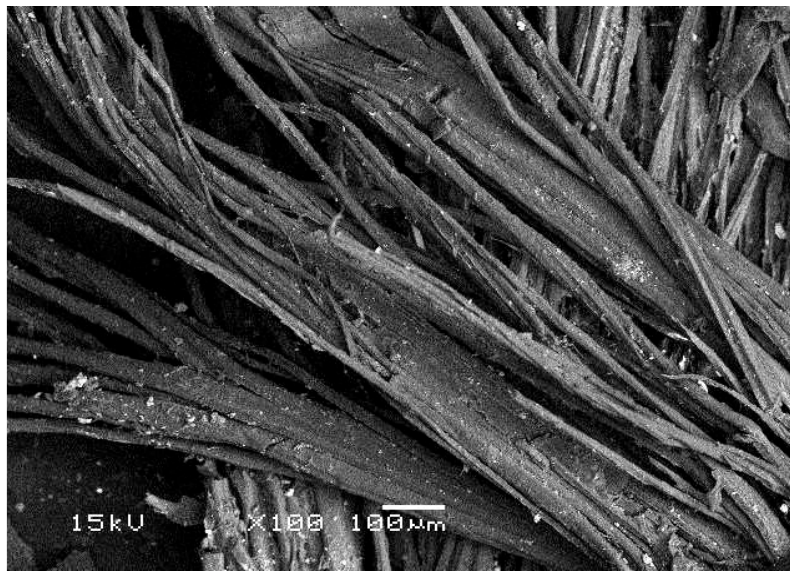
Figure 7. SEM micrograph of sugarcane bagasse.